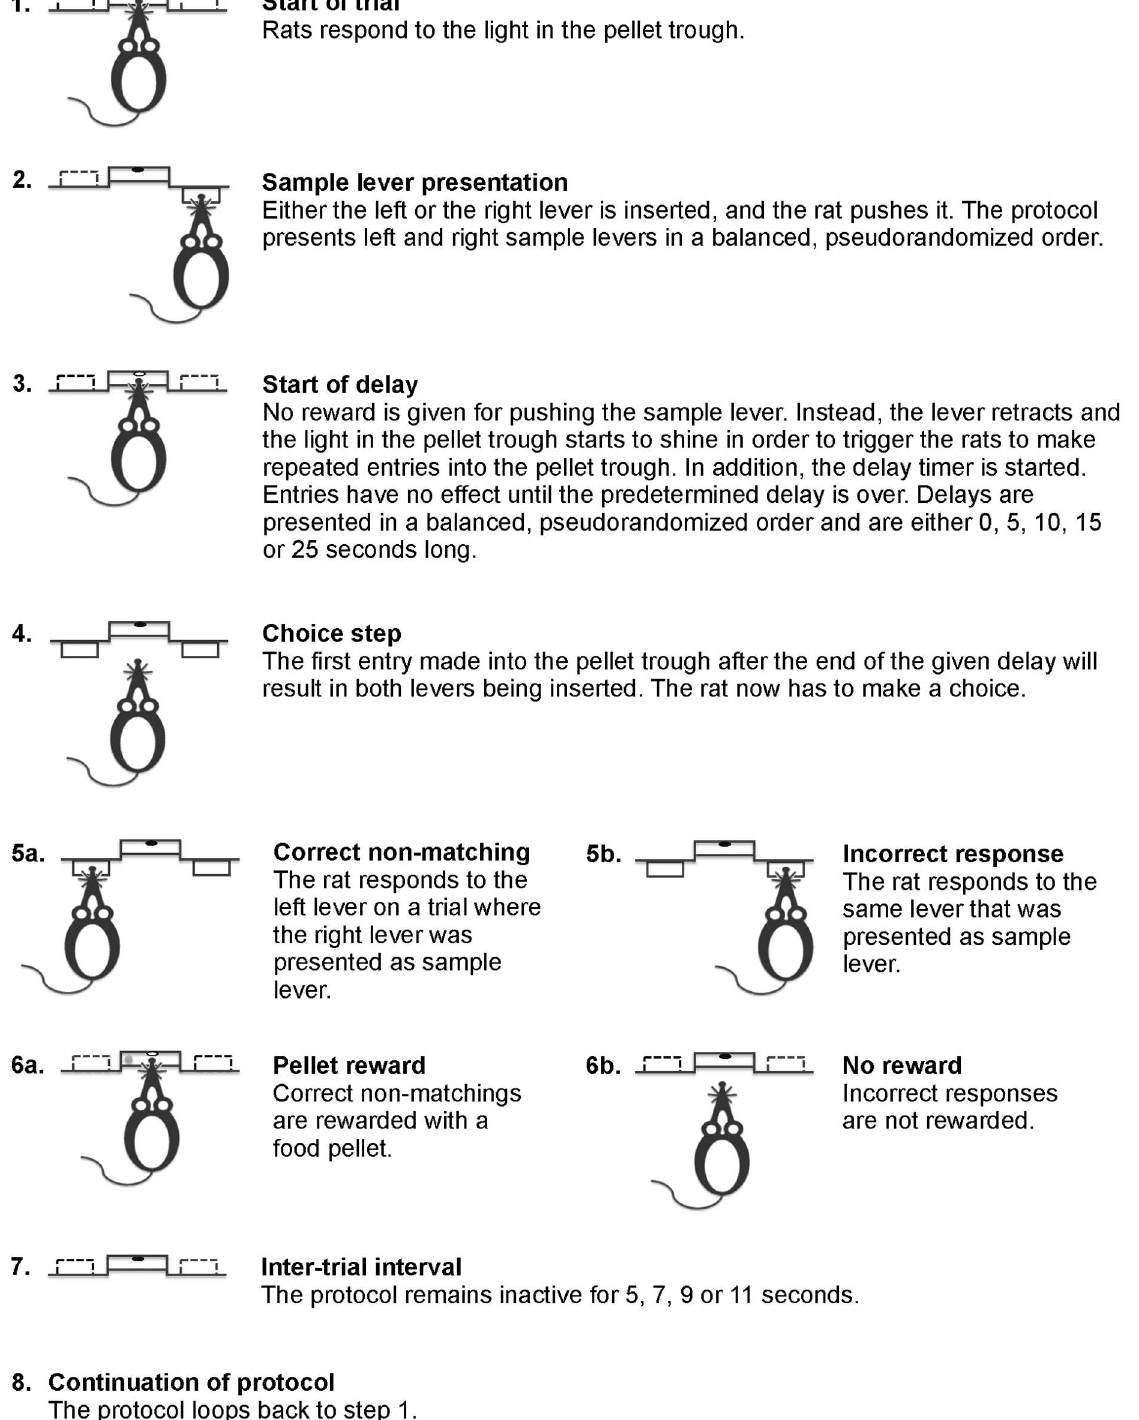
Fig 2. Delayed non-matching to position protocol. The figure describesthe steps that make up individual trials in the delayed non-matching to positionprotocol.